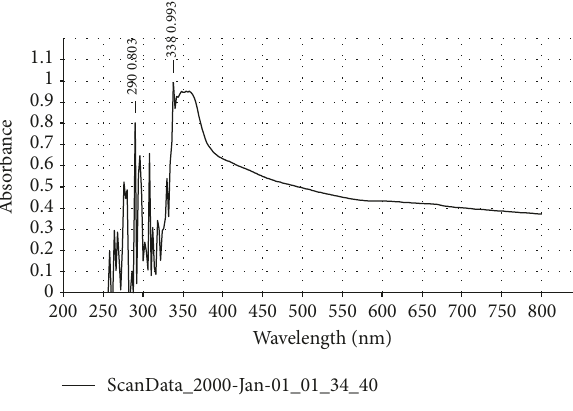
Figure 1: UV-Vis spectrum of ZNPs.